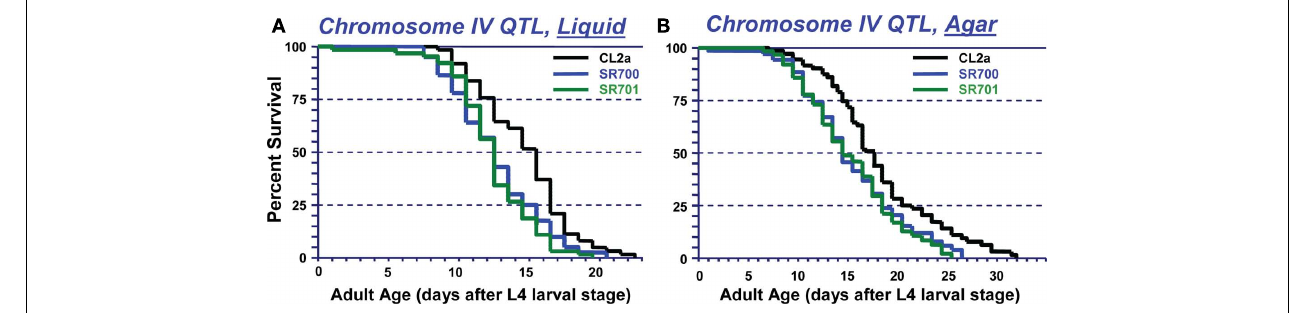
in liquid medium. (B) Survivals on solid agar medium. Protocols for nematode culture, scoring, and survival analysis are described in the “Materials and Methods” section. Each survival group was initiated with 56–70 worms at late L4, on two plates; after exclusion of censored losses, total numbers of natural deaths ranged from 50 to 65. Adult age is measured from the L4/adult molt; total age is the indicated “adult age” plus 2.5days for all